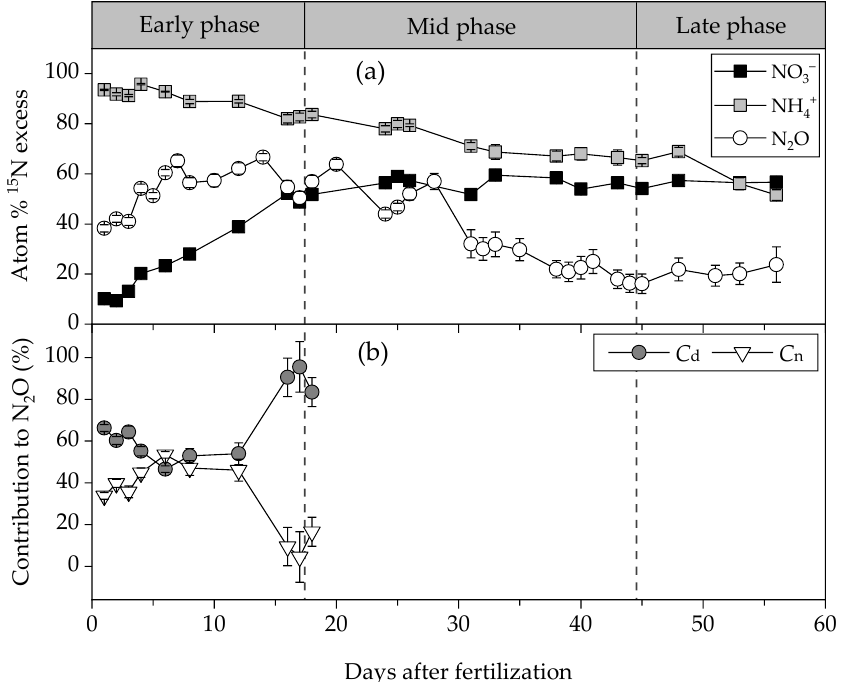
Figure 4. 15 N enrichment of nitrous oxide (N 2 O), ammonium (NH 4+ ), and nitrate (NO 3 − ) pools after 15 N labeling of field soil NH 4+ ( a ) and contributions of autotrophic nitrification ( C n ) or heterotrophic denitrification ( C d ) to N 2 O emissions ( b ). The observational period and meaning of each error bar are found in the footnotes of Figure 2.